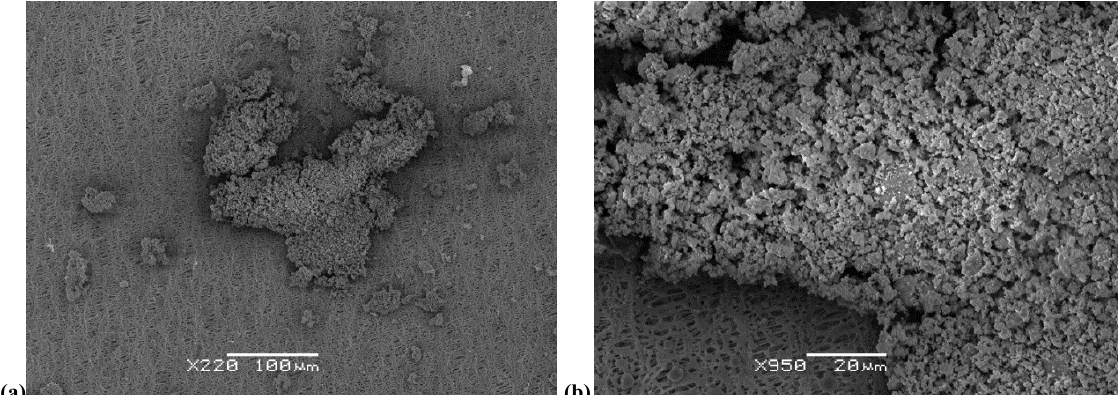
Figure 7. Scanning electron microscopy (SEM) images of aggregates (gold-coated, secondary electron imaging, high vacuum) for